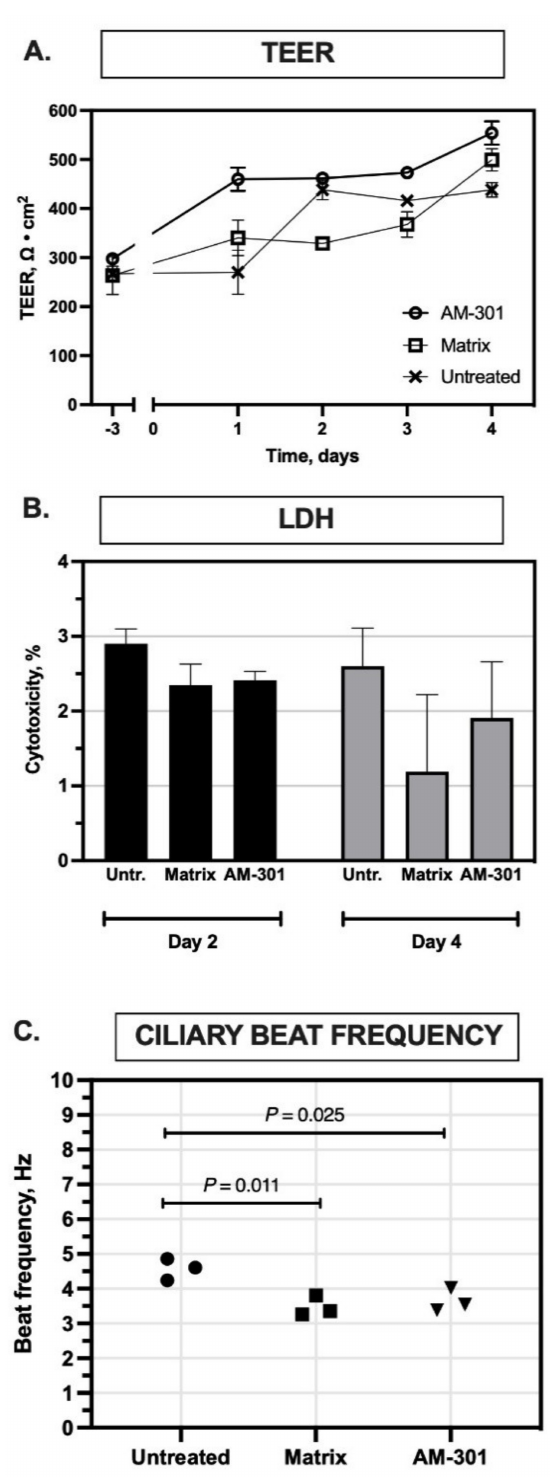
Figure 1. In vitro safety of AM-301 on MucilAir inserts (human nasal airway epitheliums). ( A ) Transepithelial resistance (TEER) over 4 days of exposure to AM-301 or its matrix lacking ben- tonite. ( B ) Lactate dehydrogenase (LDH) release assay for cytotoxicity. Data are expressed as a percentage of the amount of LDH released by lysed cells. ( C ) Ciliary beat frequency after 4 days of exposure to AM-301 or its